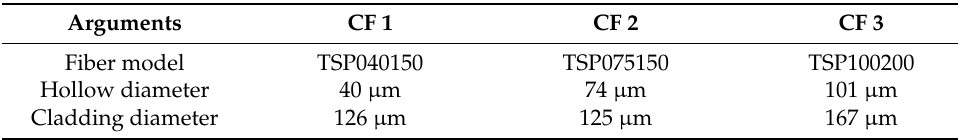
Table 1. Physical parameter table of three types of